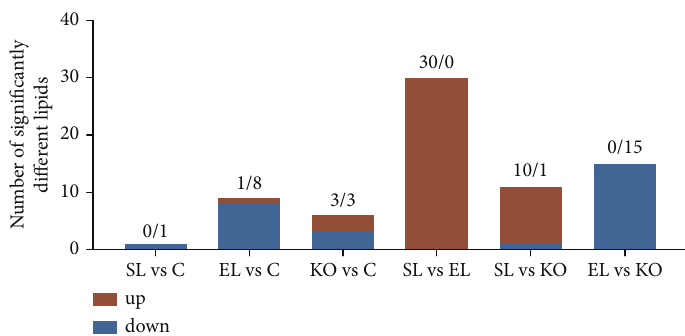
Figure 7: Number of signi fi cantly changed lipid molecules in the ovary of C. quadricarinatus fed diets with di ff erent phospholipid sources for 10 weeks.